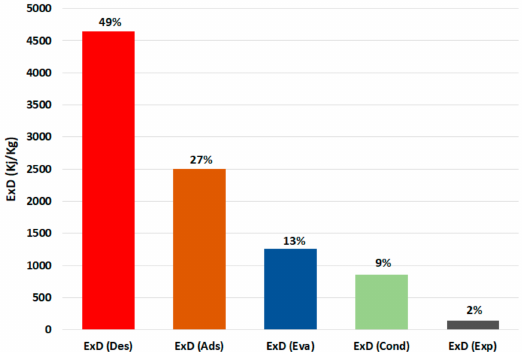
Figure 7. Exergy destruction in the chiller component at 30 ◦ C recooling-water temperature. (Ex: exergy destruction, Des: desorber, Ads: adsorber, Eva: evaporator, Cond: condenser, Exp: expansion valve).